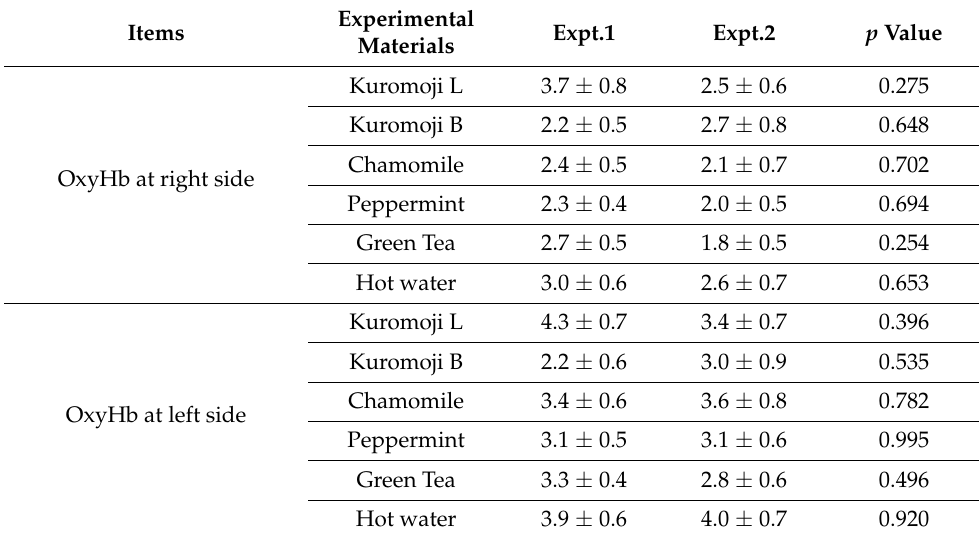
Table 3. Relative values in oxygenated